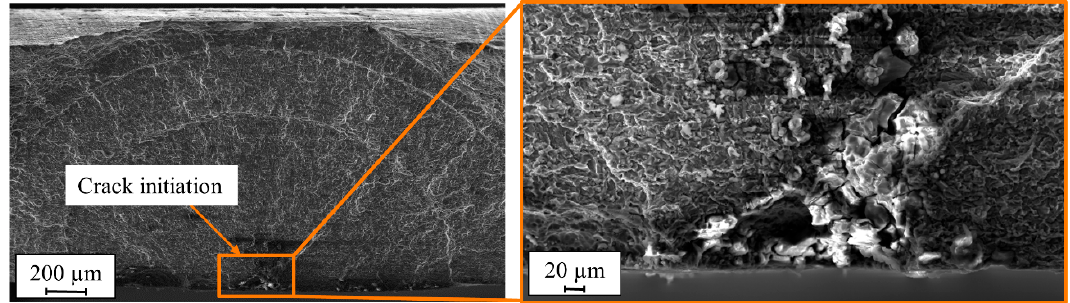
Figure 23. SEM images of the fractured surface of friction stir welded (FSW) EN AW-5754 specimen after the salt spray test.